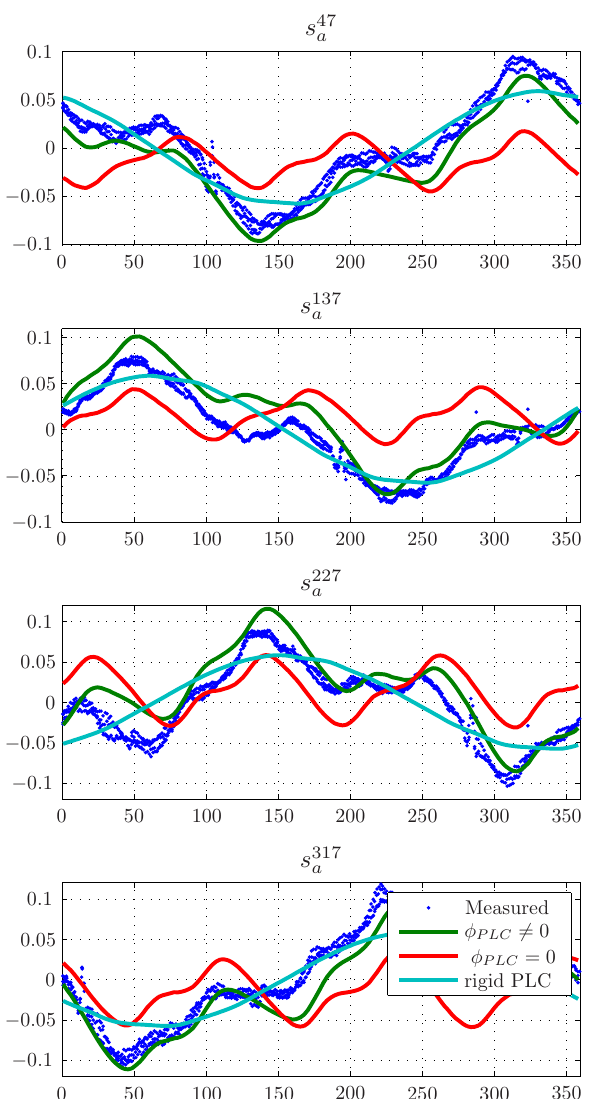
Figure 14: Comparison between measured and simu- lated deflection of the PLC (LC2).